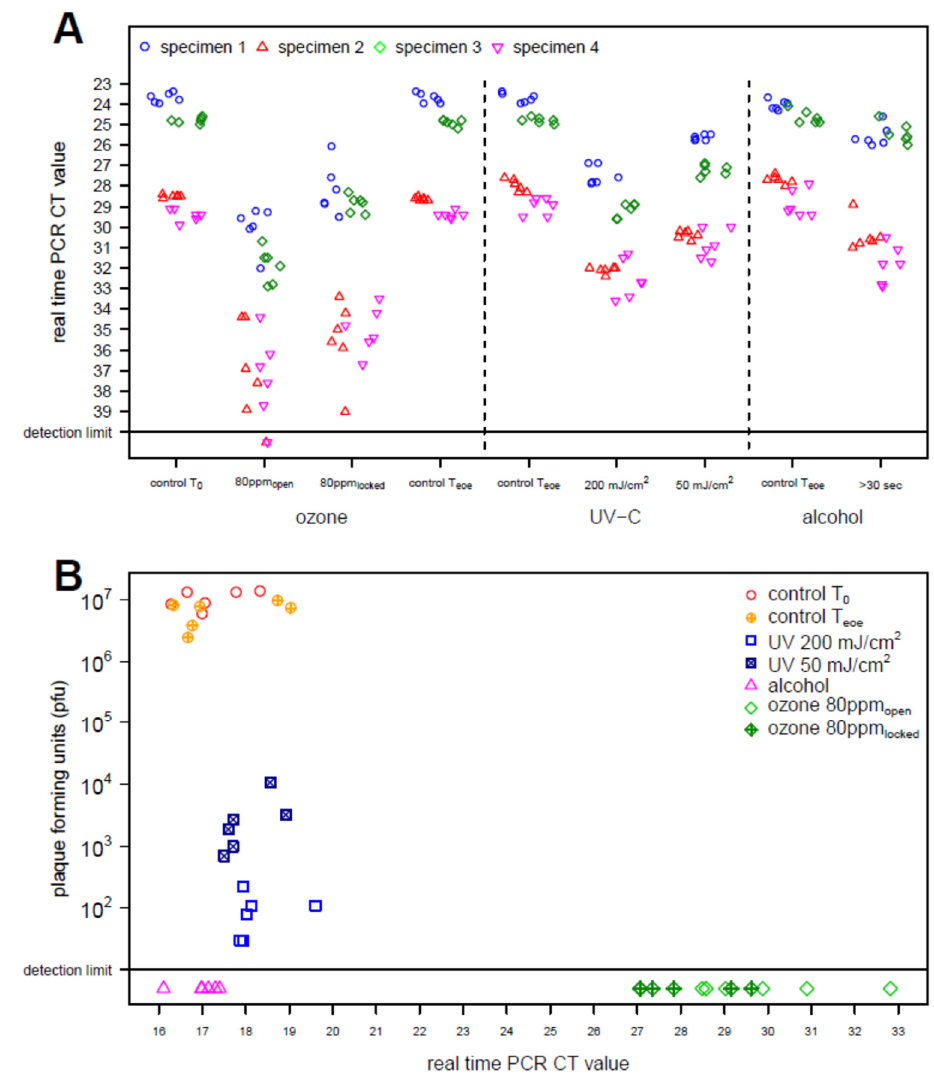
Figure 2. Decrease in Ct values with different disinfection procedures. PCR Ct values for artificially contaminated test surfaces before and after the application of different disinfection methods for SARS-CoV-2 ( A ) and the surrogate enveloped bacteriophage Φ 6 ( B ) are displayed. For surfaces artificially contaminated with SARS-CoV-2-positive patient specimen, the shape and color of the marks identify the experiments with materials from four different patients. Marks below the solid line represent PCR results below the detection limit. Dashed lines separate the results of different disinfection methods. Disinfection with ozone was performed openly (80 ppm open ) in the room or in a gas-tight can with only two 3 mm boreholes (80 ppm locked ). Due to the long disinfection cycle during ozone disinfection a second control at the end of the experiments was performed (T eoe ). For disinfection using UV-C, two radiation intensities (200 mJ/m 2 and 50 mJ/m 2 ) were examined. To correlate infectivity with Ct values, untreated surfaces and surfaces treated with the individual methods were compared after contamination with the surrogate enveloped bacteriophage Φ 6 ( B ). The surfaces were treated as described for SARS-CoV-2. The shape and color of the marks indicate the different disinfection processes and controls. The Ct values observed with PCR are plotted against the plaque-forming units displaying infectivity of Φ